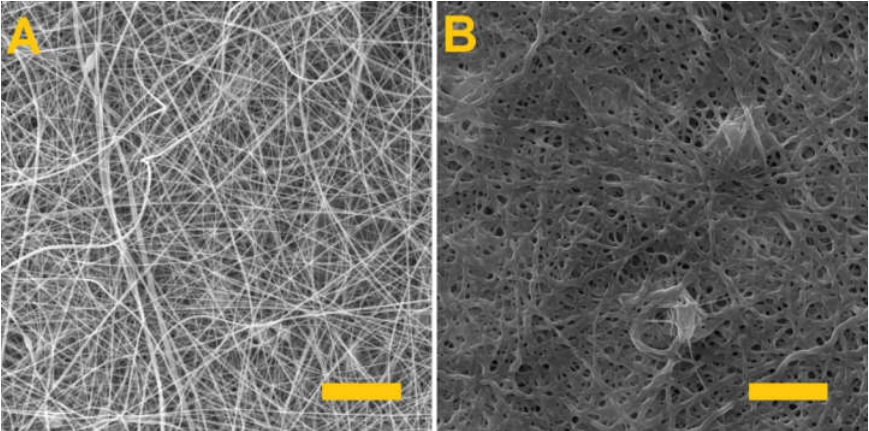
Figure 8. The PVA/alginate fiber layer with albumin. ( A ) Fiber layer before crosslinking; scale 50 μm. ( B ) Fiber layer after 4 h of crosslinking; scale 10 μm.